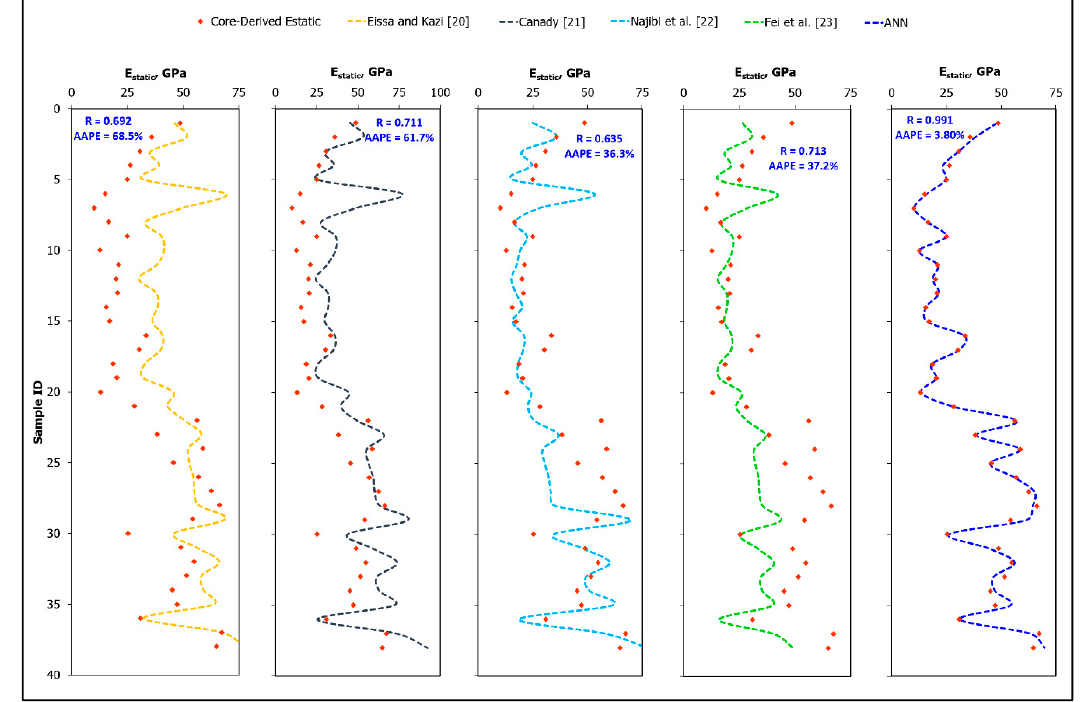
Figure 9. Comparison between predictive accuracy of Eissa and Kazi [20], Canady [21], Najibi et al. [22], Fei et al. [23], and ANN-based correlations in estimating E static for the validation dataset of Well-B.